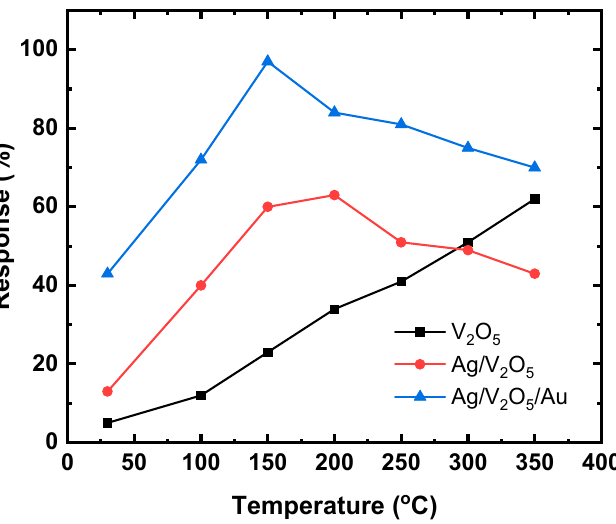
Figure 6. Response curves of the V 2 O 5 , Ag NPs/V 2 O 5 thin film, Ag NPs/V 2 O 5 thin film/Au NPs sensors exposure to 50 ppm acetone gas as a function of working temperature.